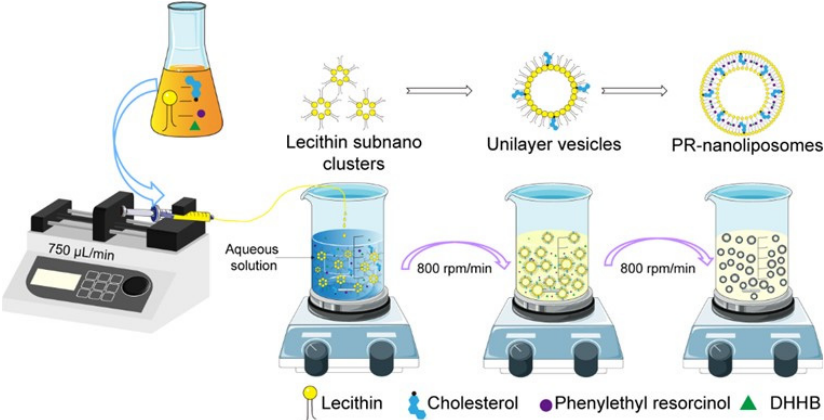
Figure 1. The schematic representation of PR-NLPs preparation process.